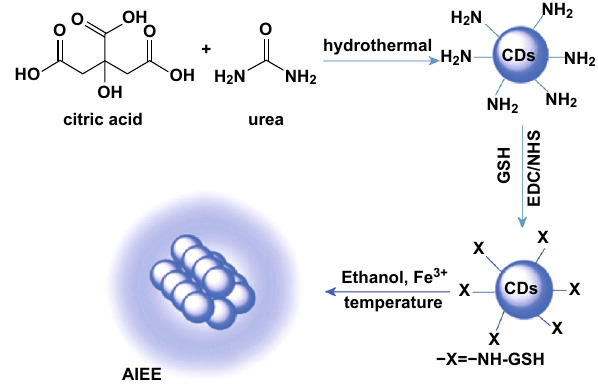
Fig. 15 Preparation of CDs by hydrothermal treatment of CA and urea and sensing based on aggregation-induced emission enhance- ment effects [132]. Copyright (cid:2) 2016 The Royal Society of